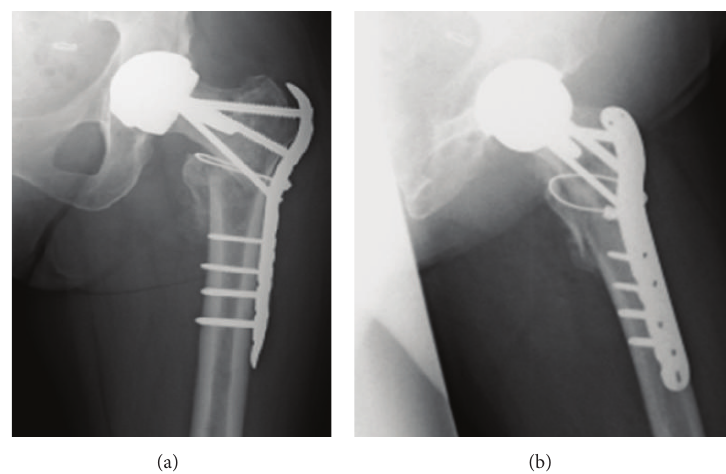
Figure 5: (a)-(b) Images taken at 6-week postoperation review.